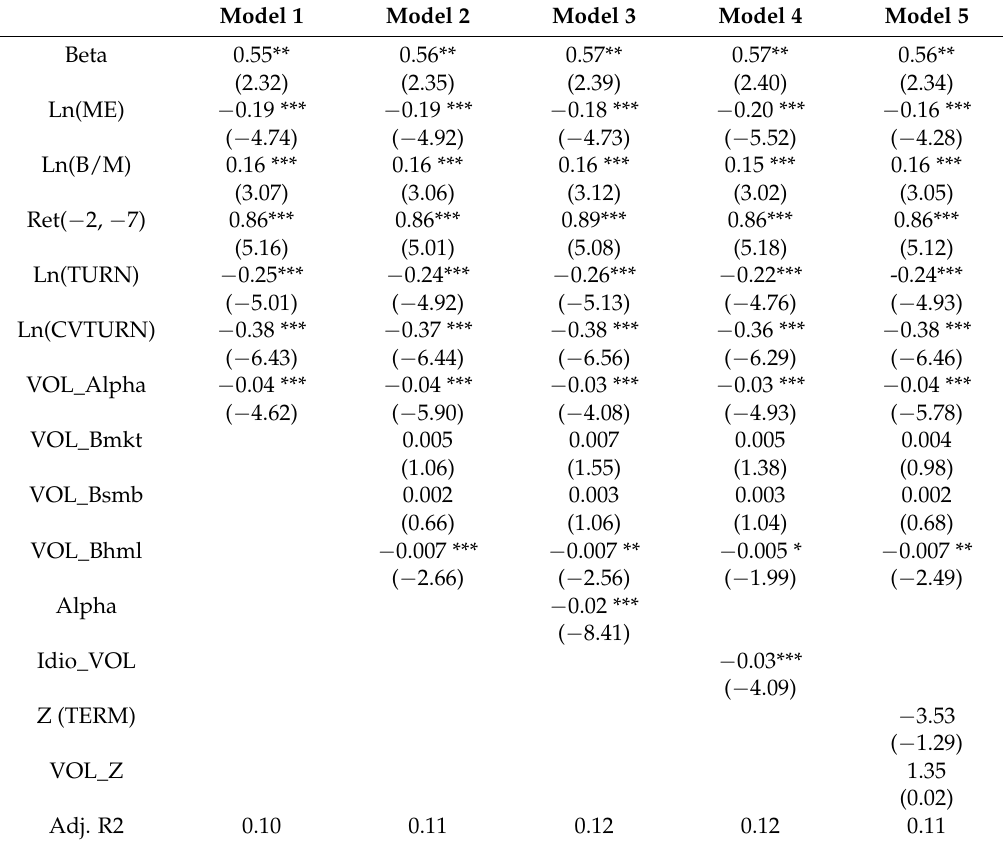
Table 7. Firm-level cross-sectional